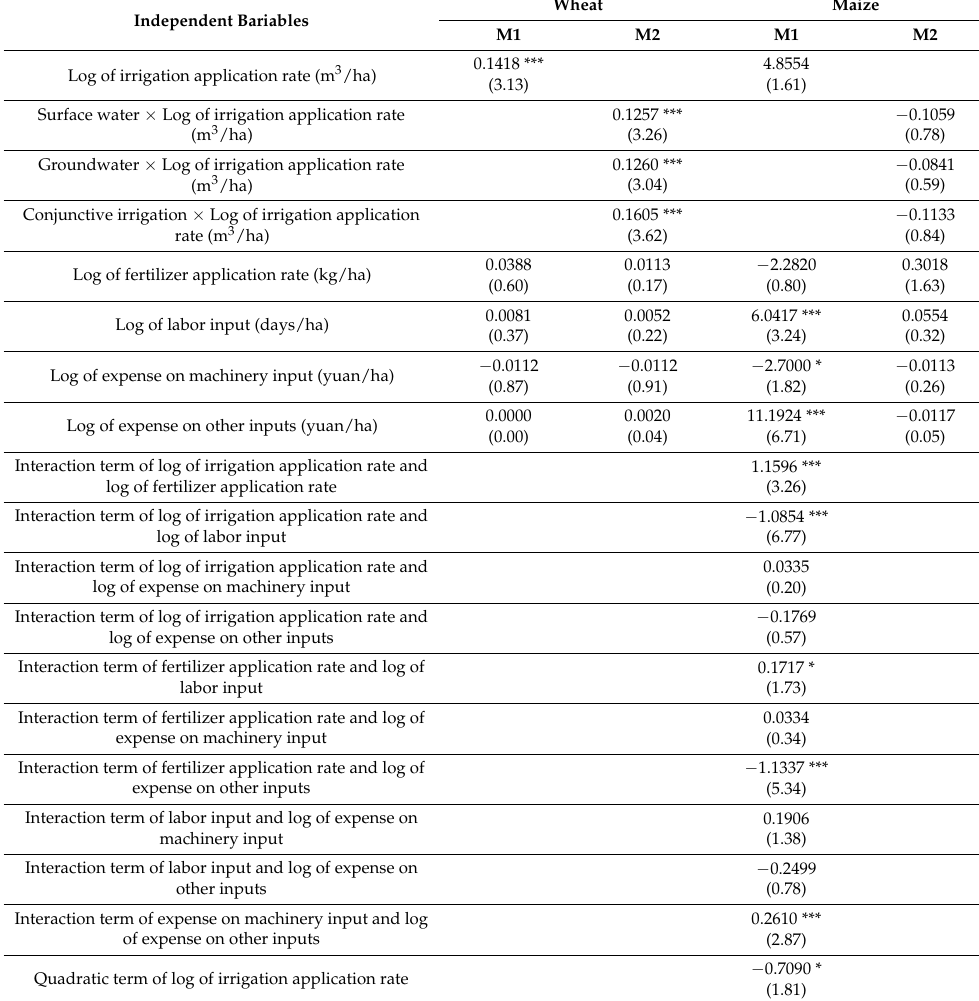
Table 6. Dependent variables: log of crop yield